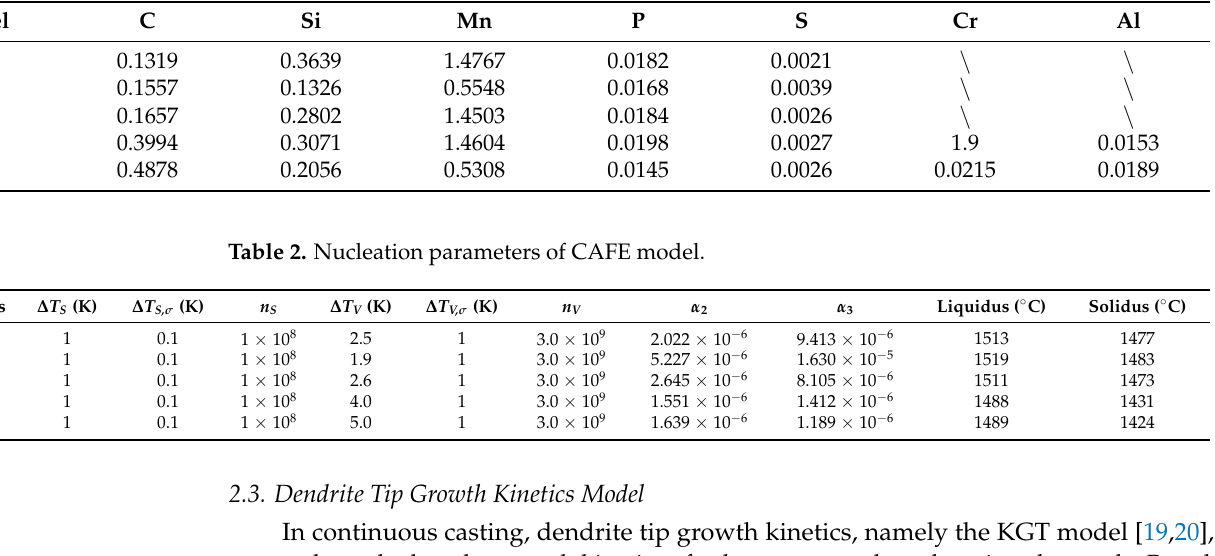
Table 1. Chemical compositions (mass%) of the slab under investigation.